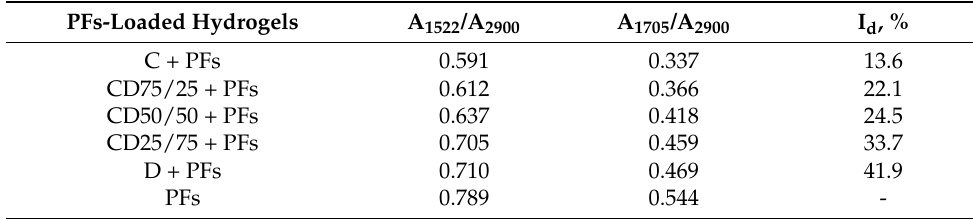
Table 5. ATR-FTIR spectral characteristic for CD hydrogels, with or without PFs.